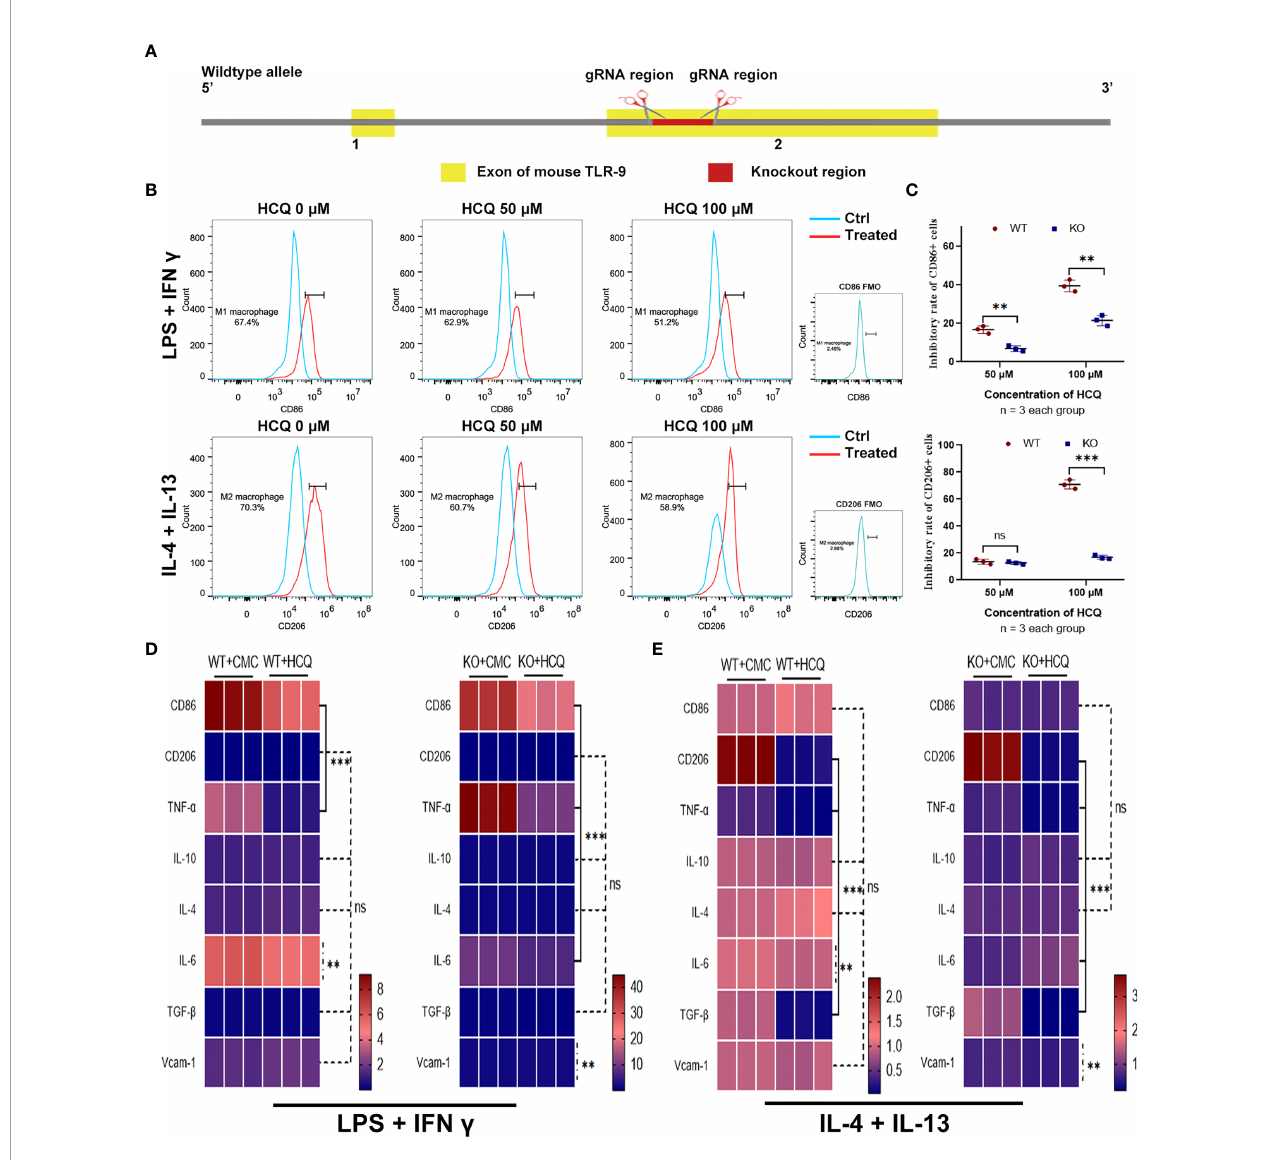
FIGURE 4 | Effects of HCQ on differentiation of BMDMs are reduced after depletion of TLR-9 in vitro . (A) Overview of the target strategy. (B) Effects of HCQ on polarization of TLR-9 − / − macrophages. TLR-9 − / − BMDMs were polarized into M1 or M2 subsets, and various concentrations of HCQ were added for 24 h to assess the effects of HCQ on differentiation of macrophages. (C) Quanti fi cation of the rate of inhibition. (D) Heatmap of mRNA expressions related to macrophage polarization when stimulated with LPS + IFN- g . (E) Heatmap of mRNA expressions related to macrophage polarization when stimulated with IL-4 + IL-13. Data are represented as means or means ± SD and analyzed using the Student ’ s t test. NS, no signi fi cant difference; **P < 0.01, ***P <